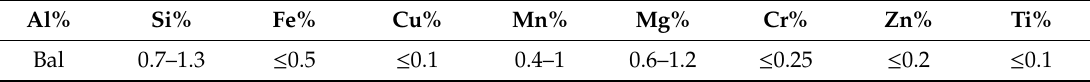
Table 1. Chemical composition of the AA6082 under investigation.